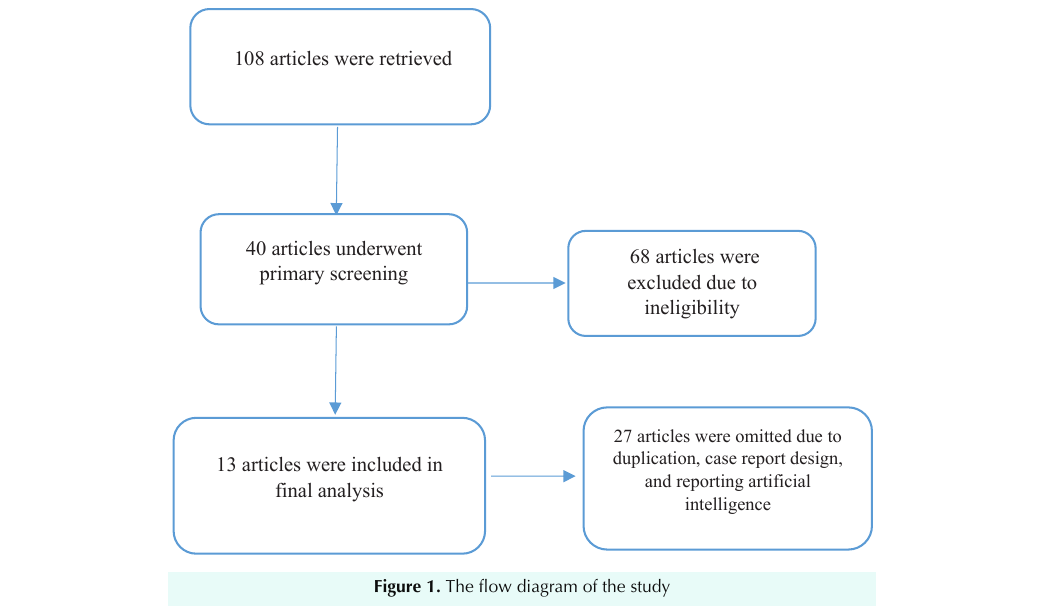
Figure 1. The flow diagram of the